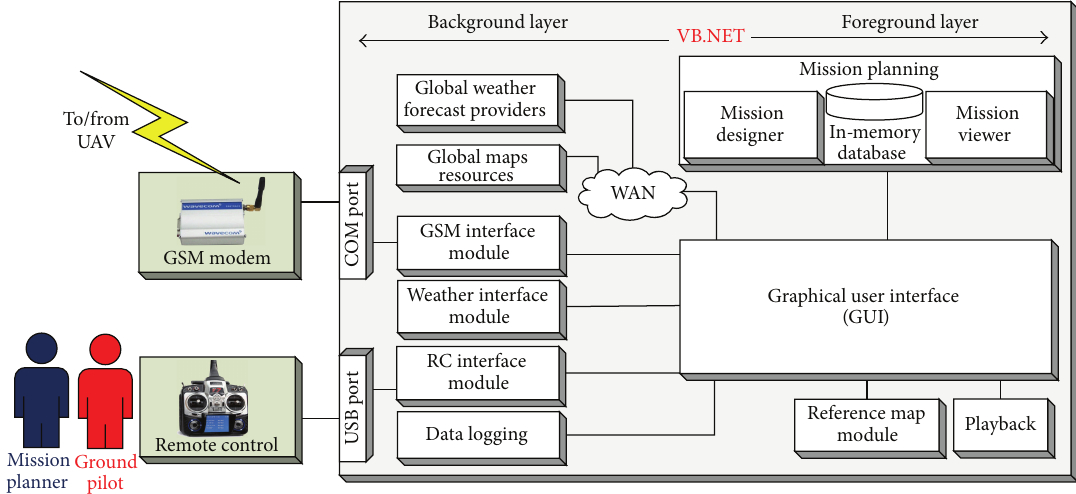
Figure 6: Ground Control Station block